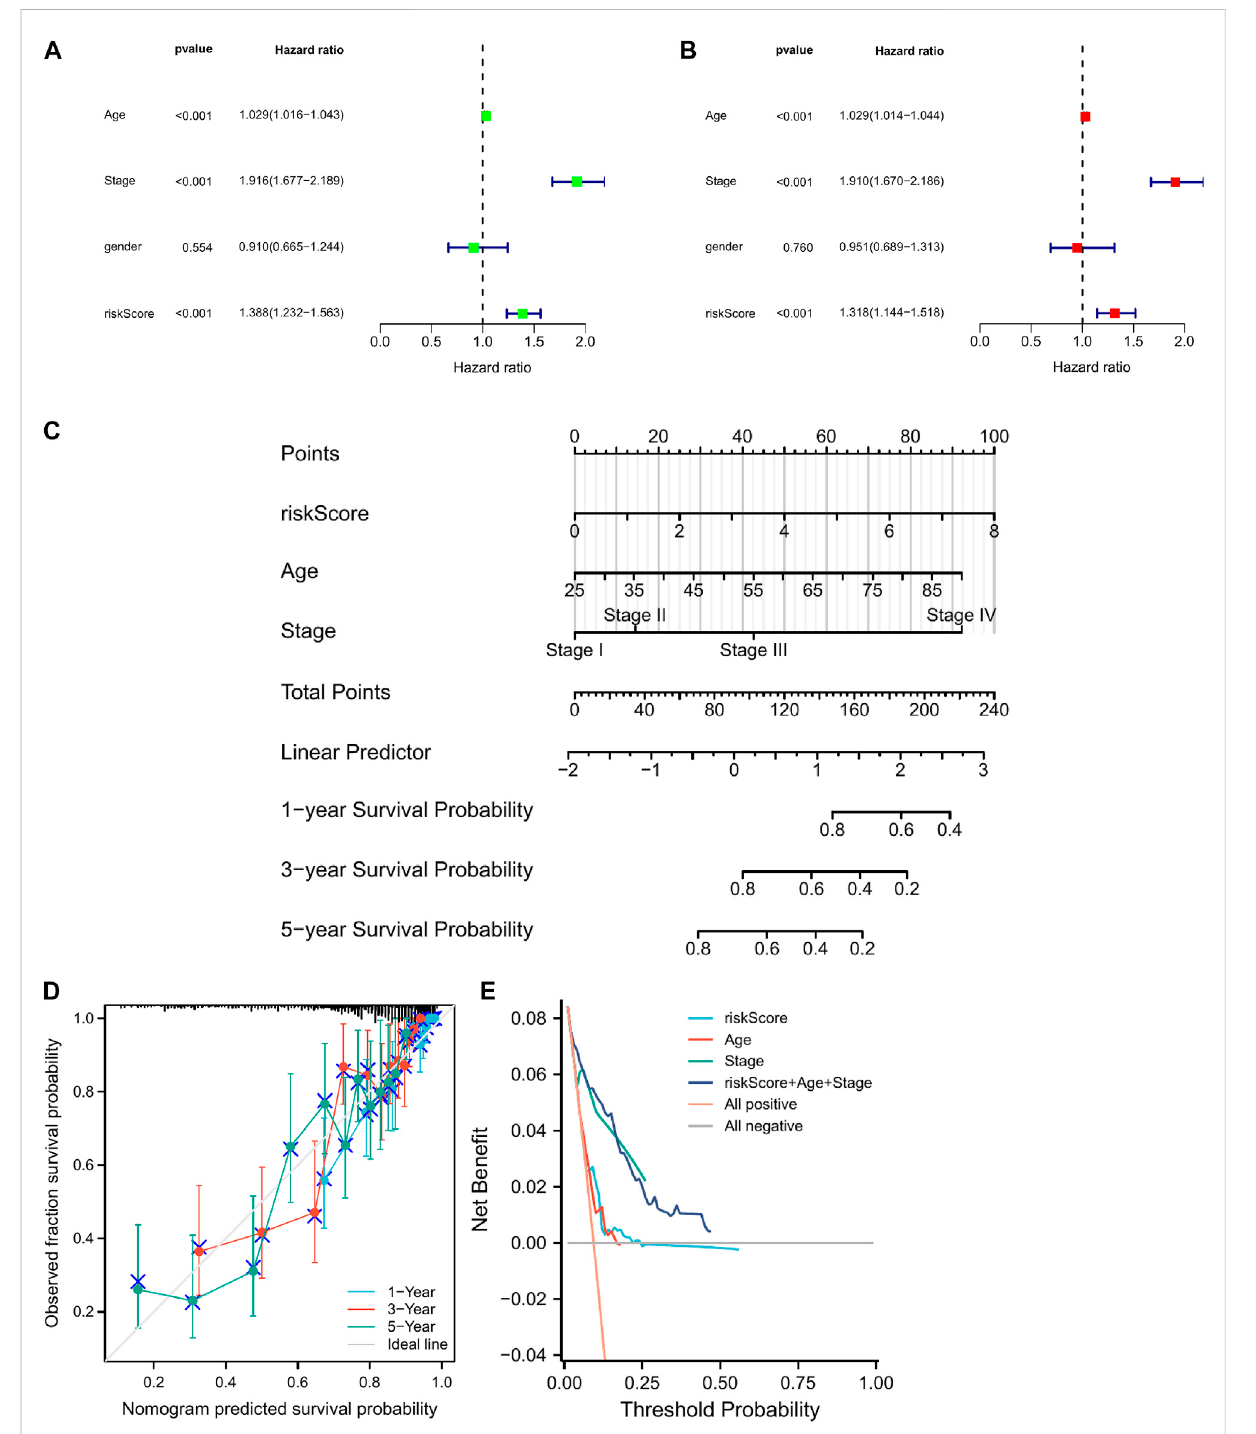
FIGURE 5 The construction of a nomogram for predicting survival. (A,B) Screening the independent predictors for OS in KIRC by univariate and multivariate Cox proportional hazards regression model. (D) A nomogram including risk score and clinicopathological features was constructed to predict1/3/5-year OS. (C) Thecalibrationplots forpredicting1/3/5-year OS arebasedon theCRGs nomogram. (E) Decisioncurveanalysis(DCA)for the evaluation of the net bene fi ts of CRGs and